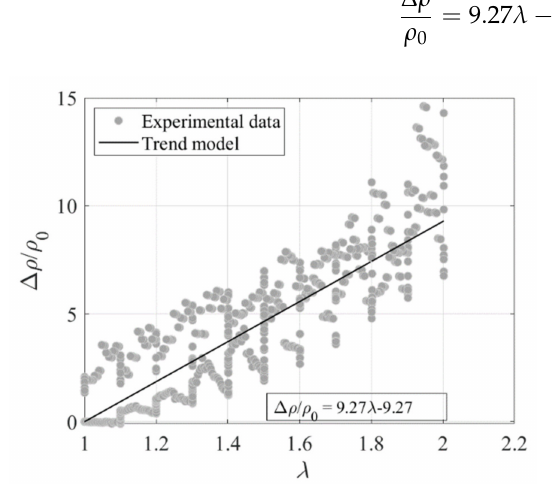
Figure 14. Variation of normalised resistivity with stretch